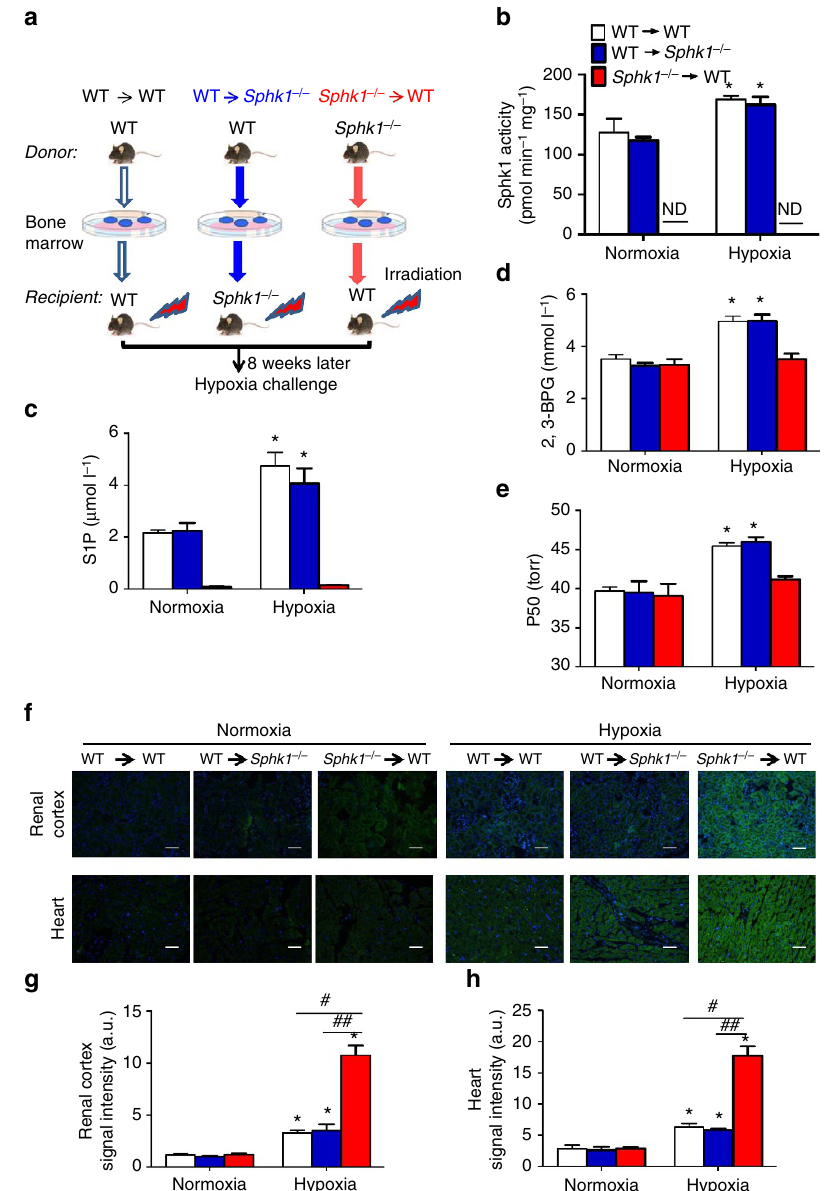
Figure 3 | Bone marrow-derived Sphk1 and S1P are responsible for protecting tissue hypoxia by inducing erythrocyte 2,3-BPG levels and O 2 release capacity. ( a ) Schematic illustration of reciprocal bone marrow transplantation (BMT) between WT and Sphk1 (cid:2) / (cid:2) mice. Erythrocyte Sphk1 activity ( b ), S1P ( c ), 2,3-BPG level ( d ) and P50 ( e ) in each group of mice in normoxia and hypoxia for different treatment times. ( f ) Tissue hypoxia signals measured by Hypoxyprobe in renal cortex and heart in each group of mice in normoxia and hypoxia for 72h. Quantification of hypoxia signals in renal cortex ( g ) and heart ( h ). Mean ± s.e.m; n ¼ 8 per group of mice; * P o 0.05 versus normoxia, # P o 0.05 versus WT to WT, ## P o 0.05 versus WT to Sphk1 (cid:2) / (cid:2) , Student’s t -test and one-way ANOVA. Scale bar, 50 m M. detectable activity in cultured erythrocytes isolated from to increase intracellular S1P, under normoxia and hypoxia Sphk1 (cid:2) / (cid:2) mice under both normoxia and hypoxia condition (Supplementary Fig. 4a). Moreover, we found that hypoxia directly induced 2,3-BPG levels in cultured erythrocytes from WT mice but not Sphk1 (cid:2) / (cid:2) mice (Supplementary Fig. 4b,c), indicating that hypoxia-induced erythrocyte Sphk1 activity is required for 2,3-BPG production in mouse erythrocytes. Next, to determine if extracellular S1P signalling via its surface receptors directly induces 2,3-BPG production in erythrocytes, we hypoxia-induced Sphk1 activity-mediated elevation of S1P isolated erythrocytes from both WT and Sphk1 (cid:2) / (cid:2) mice and functions independently of S1P receptors to induce 2,3-BPG pretreated them with exogenous S1P up to 250 nmol l (cid:2) 1 , which is levels in the erythrocytes. high enough to activate all of five S1PRs 32 but insufficient NATURE COMMUNICATIONS|7:12086|DOI: